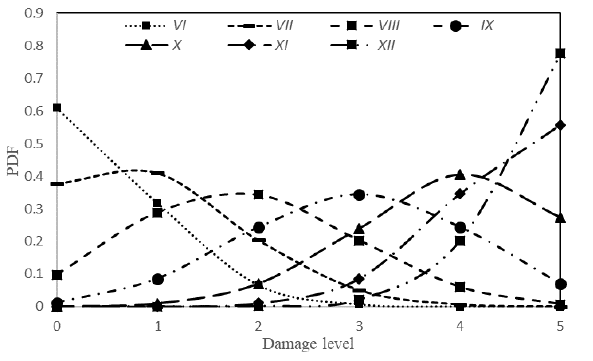
Figure 5. Binomial probability distribution for the centre of Scarperia for different macroseismic intensity